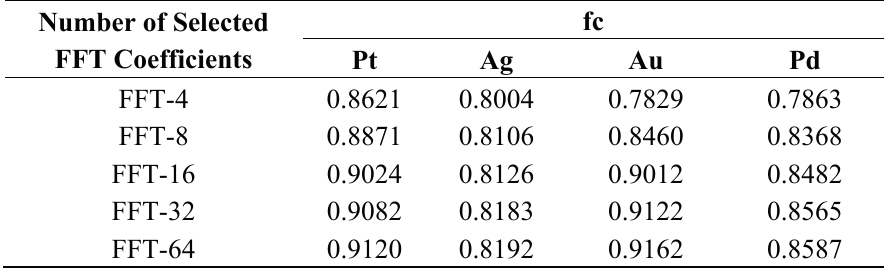
Table 2. Comparison of average fc with number of FFT coefficients for non-crushed rice